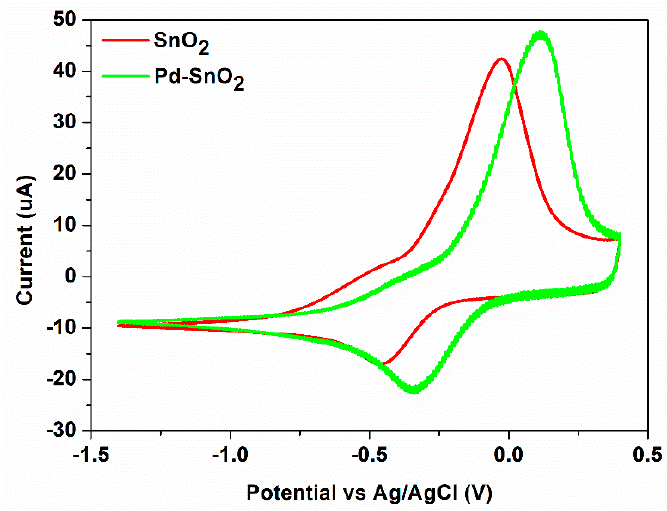
Figure 8. Cyclic voltammograms of Cu 2+ (100 ppm) in 0.1 M acetate buffer solution (pH = 5.0) recorded on red SPE-based SnO 2 and green SPE-based Pd-SnO 2 .